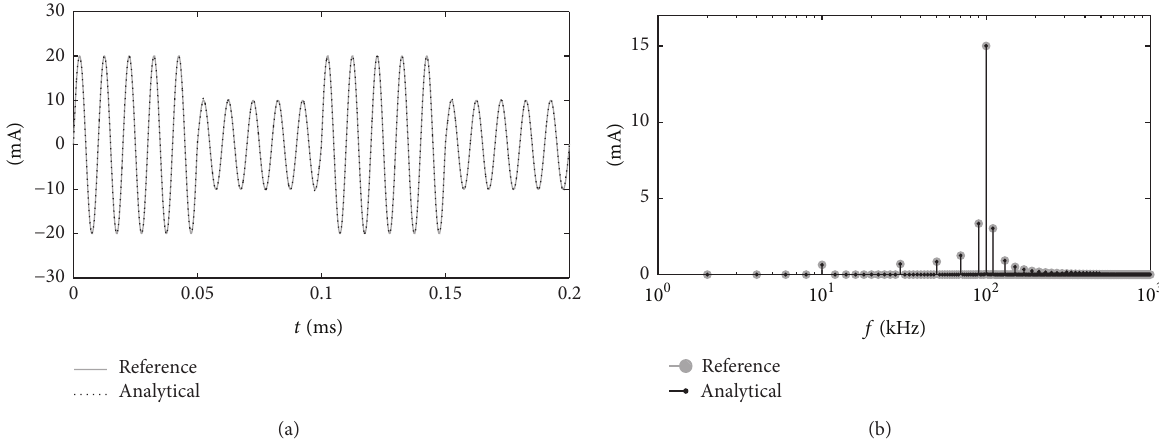
Figure 9: Time-domain response of the current 𝑖(𝑡) (a) of the example circuit in Figure 2 and its corresponding spectrum 𝐼(𝑓) (b).